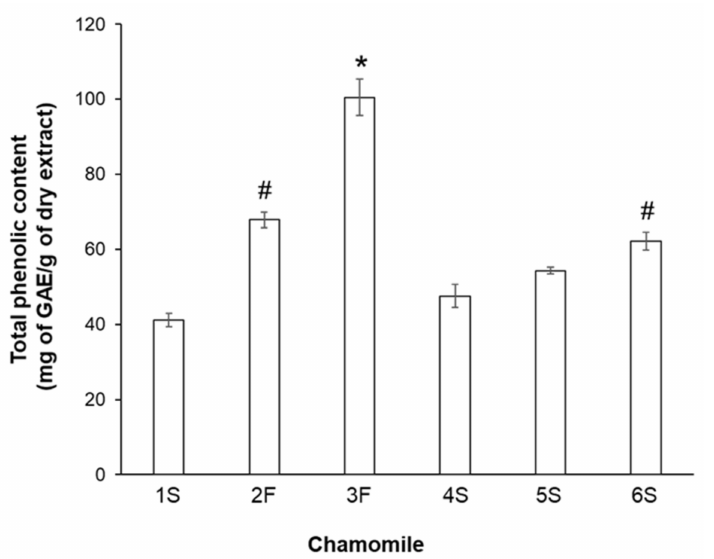
Figure 2. Total phenolic content in chamomile extracts. Reported values are expressed as milligrams of gallic acid equivalent (GAE) per gram of dry matter extract (mg of GAE/g dry extract). * p < 0.01 vs. all other samples; # p < 0.05 vs. 1S, 4S, and